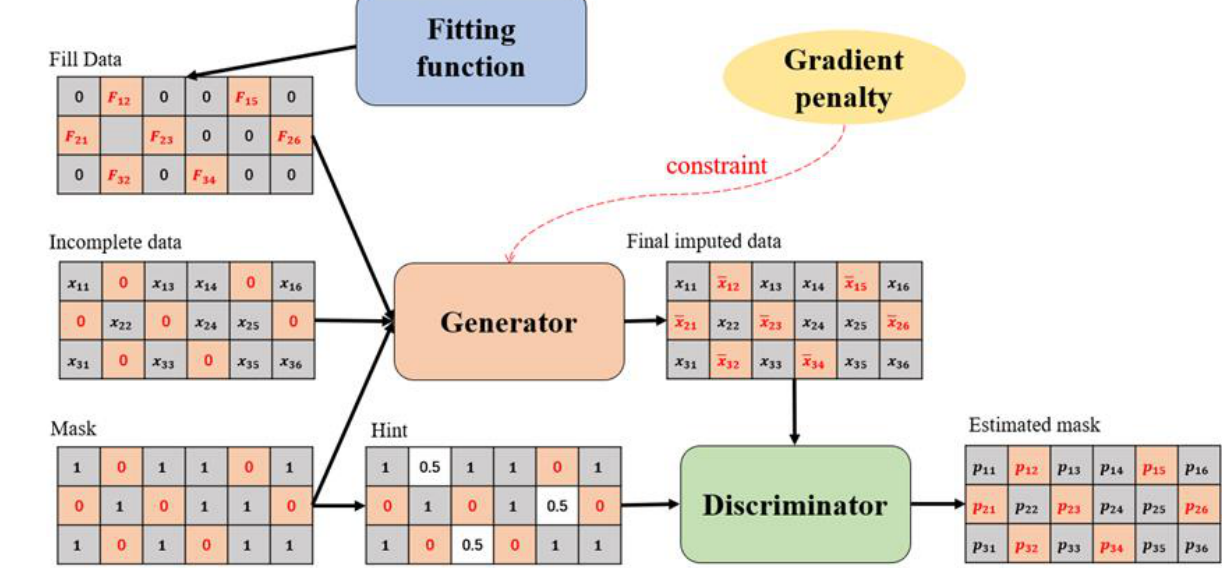
Figure 2. The framework of WFGAIN-GP. The temporarily padded data, original data, and mask are input into the generator together. Under the constraint of gradient penalty, the generator outputs the imputed complete data. The discriminator D receives the masked data processed by the hint mechanism and the complete data generated by the generator G and then outputs the discrimination result, which is a new mask.